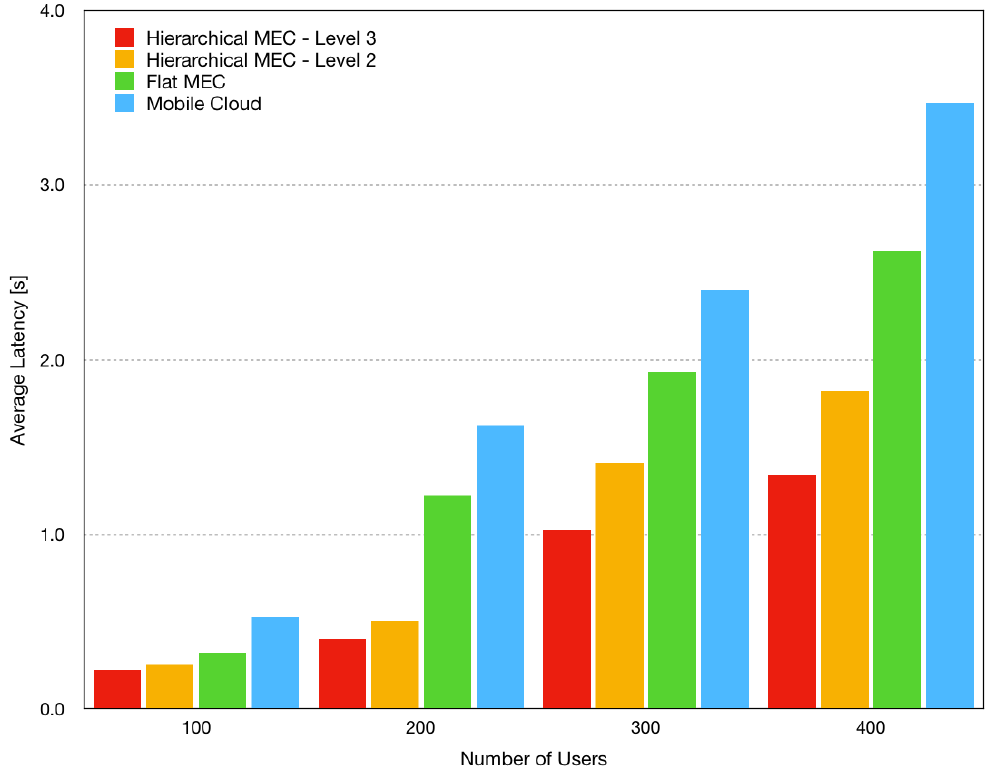
Figure 9. Average latency time.